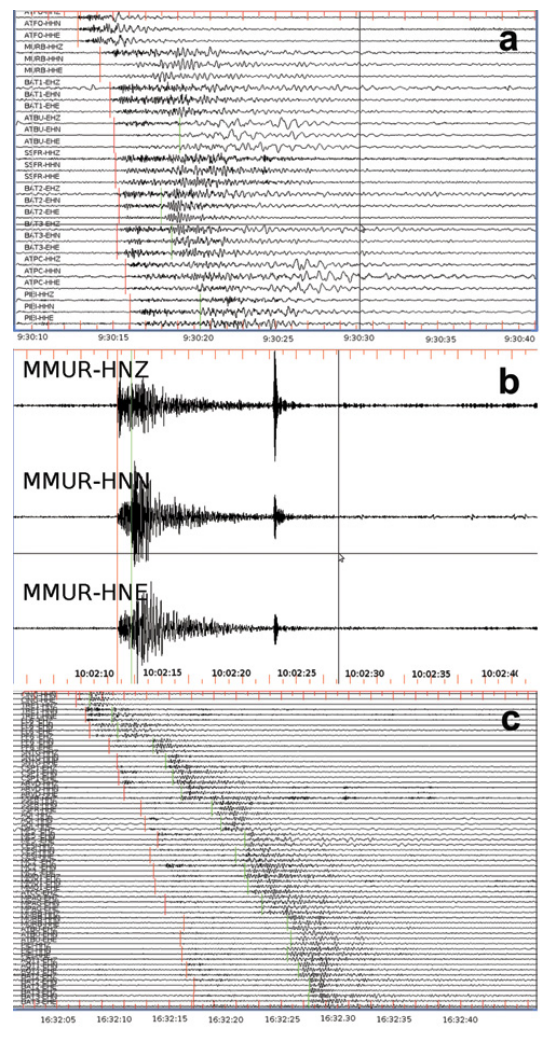
Figure 5. (a) Recordings for a quarry blast in the “Gubbio” area. Note the lack of a clear S onset, and the low-frequency signal in the coda (“ground roll”). (b) Quarry blast in the “Rossa” area recorded at the closest station MMUR (about 5 km). Note the high frequency signal about 12 s after the P wave, related to the sound propagation. (c) Recordings for a quarry blast in the “Cingoli” area. In this case identification is less